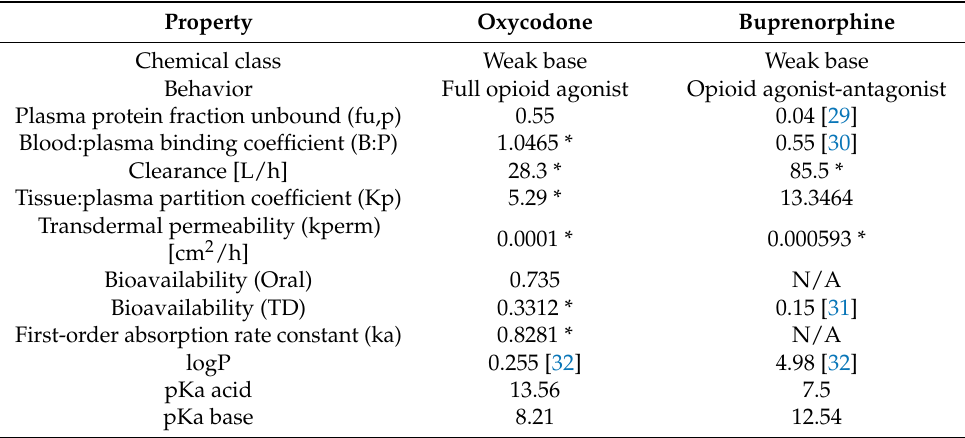
Table 1. Drug properties and PK parameter values used in simulations of Oxycodone and Buprenor- phine disposition. Values were obtained from literature, default value approximation, or machine leaning (ML) optimization. Values marked with (*) were